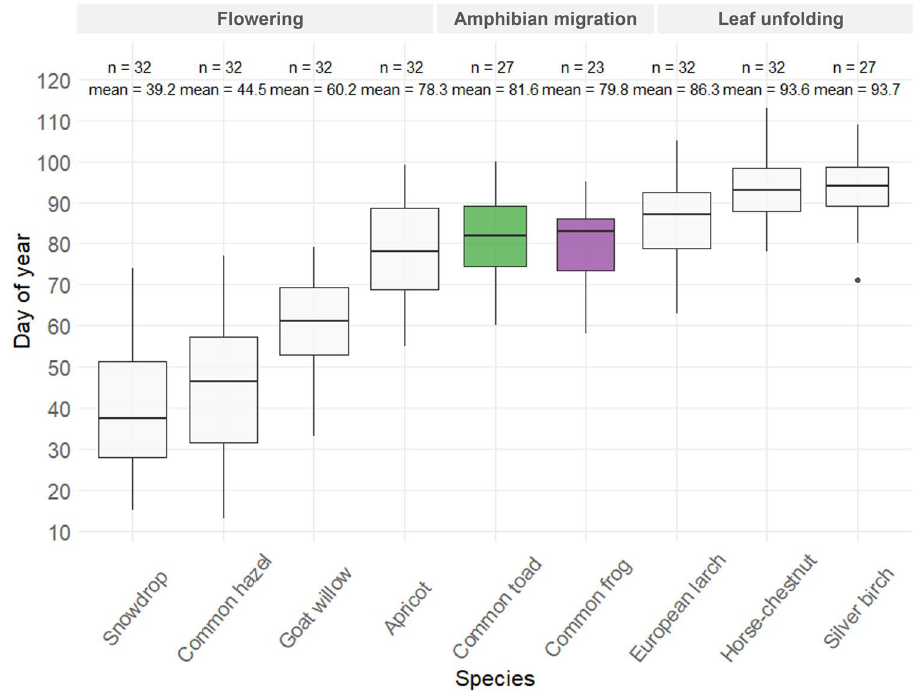
Figure 2. Onset of phenological phases flowering (snowdrop, common hazel, goat willow and apricot) and leaf unfolding (European larch, horse-chestnut, silver birch) and migration start of common toads and common frogs between the years 2000–2018 in